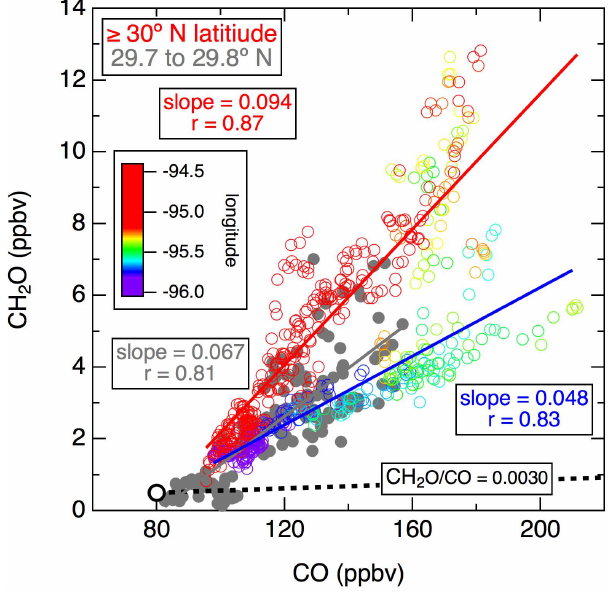
Fig. 9. Relationships between CH 2 O and CO measured by the Elec- tra on 27 and 28 August 2000 in the same format as Fig. 8. The track for the first flight is shown in Fig. 1, and the second flight track was similar. Data from within the entire plume downwind from the Houston area are included. Data are color-coding according latitude range (grey points, 29.7–29.8 ◦ N; colored points, 30.0–30.3 ◦ N) and longitude according to color-scale in plot. The lines and annotations of the respective colors indicate the linear regressions to the data sets divided by latitude range and longitude (red east and blue west of − 95.4 ◦ longitude). The dotted black line indicates the expected mixing ratio enhancements from primary emissions of CH 2 O and CO from the on-road vehicle fleet with a ratio of